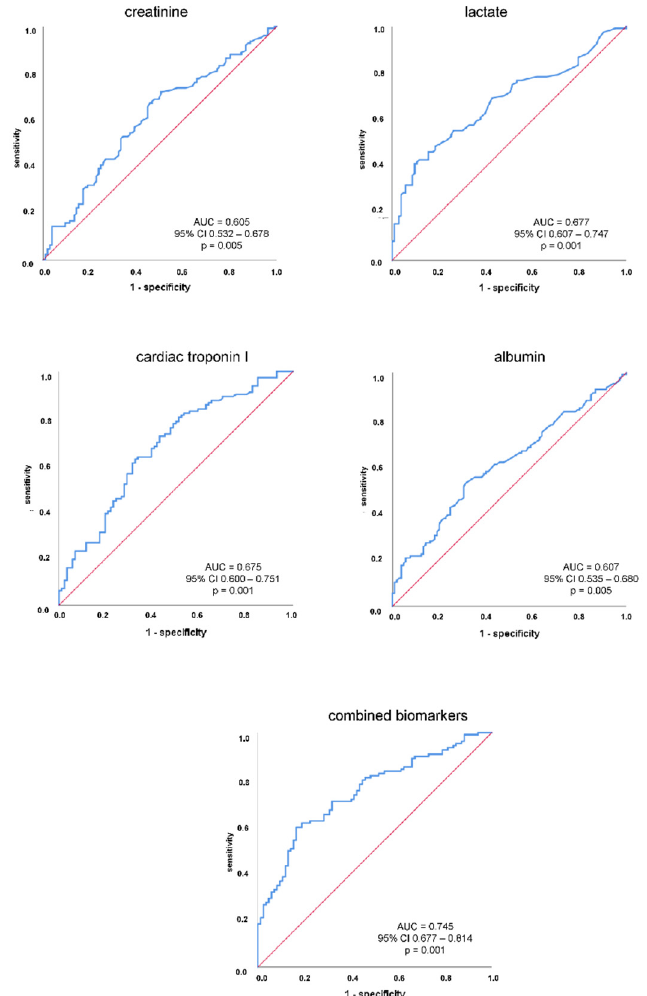
Figure 6. C-statistics for creatinine, lactate, cardiac troponin I, albumin, and the combined use of biomarkers with regard to 30-day all-cause mortality. biomarkers with regard to 30-day all-cause